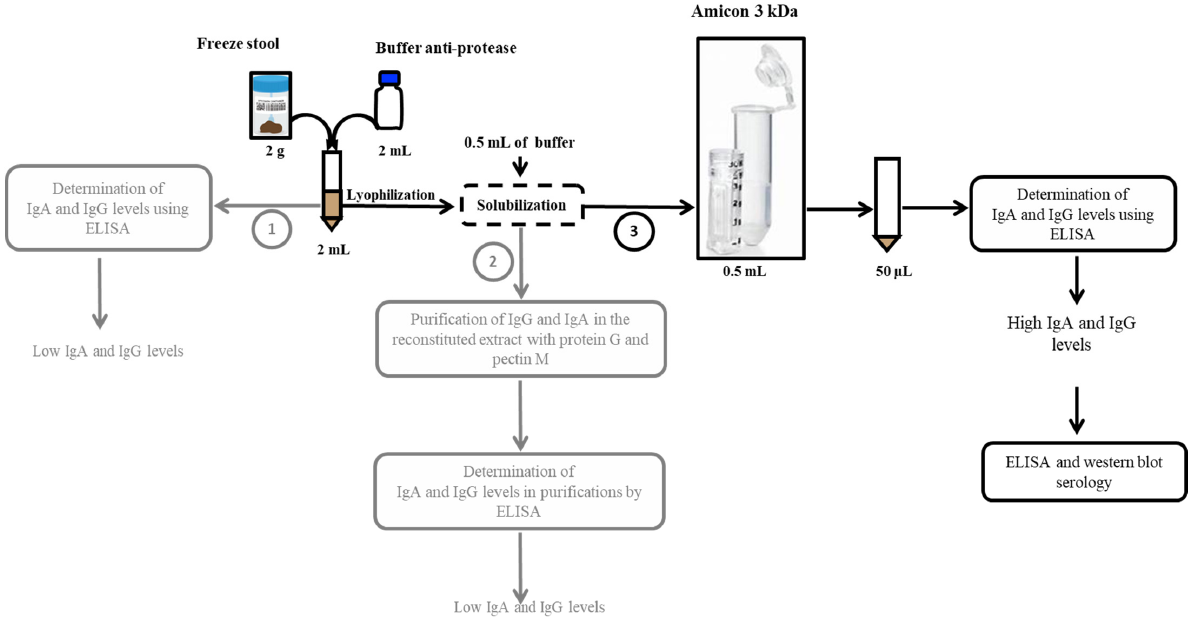
Figure 2. Schematic representation of the three protocols evaluated for protein extraction from stools up to evaluation of immunoglobulin s by ELISA and western blot. Protocol 3, indicated in black, is the one that was retained.